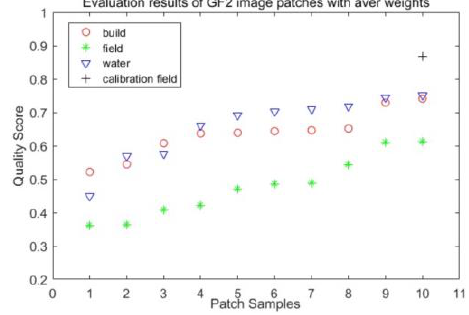
Figure 5. The evaluation result of different GF2 image